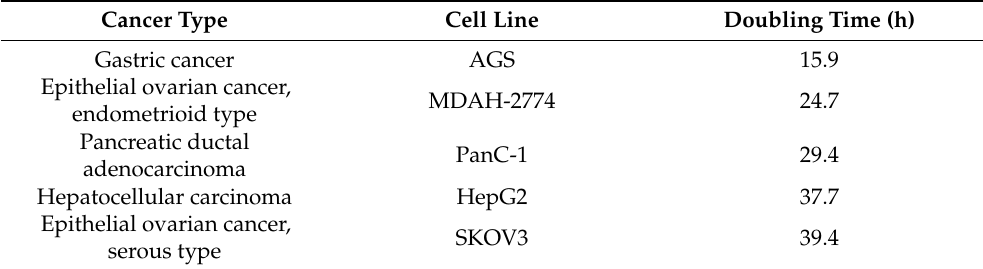
Table 1. The doubling time for different cancer types.